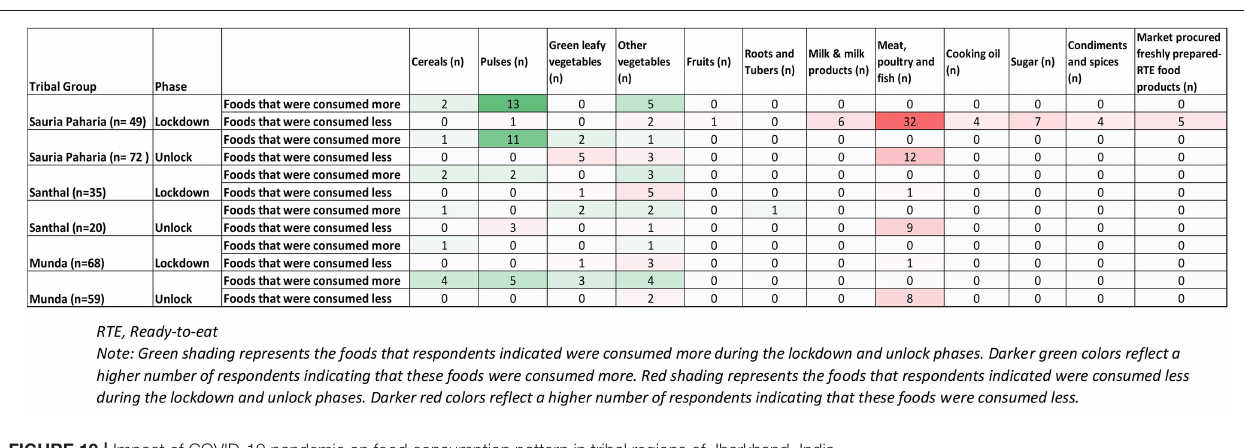
FIGURE 10 | Impact of COVID-19 pandemic on food consumption pattern in tribal regions of Jharkhand,